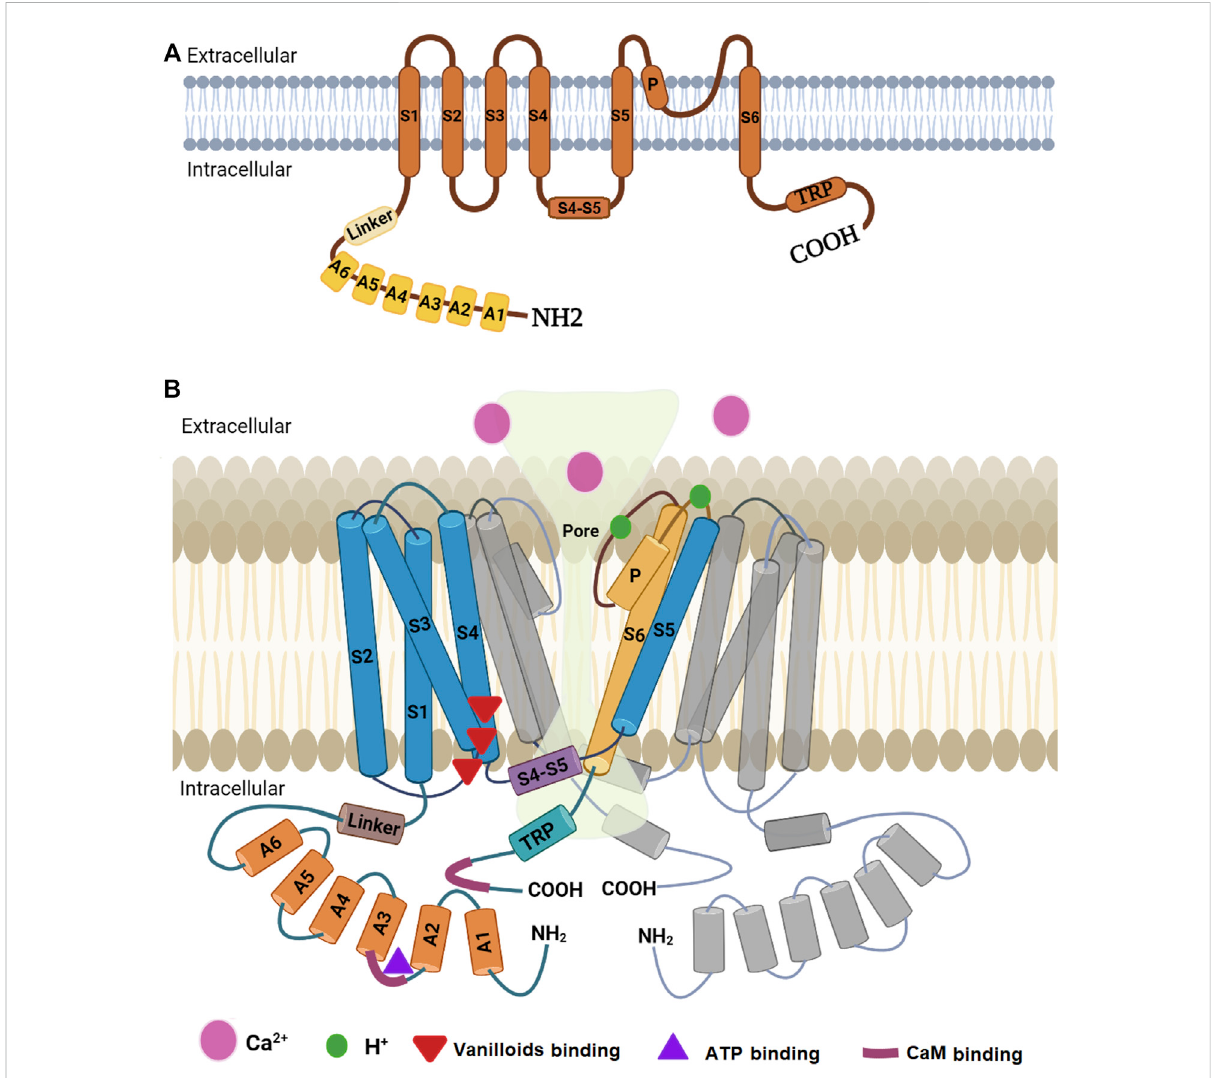
FIGURE 2 Diagrammatic structure of TRPV1. (A) One subunit showing N-terminus containing six ankyrin subunits (A1-A6) and a linker, transmembrane region with six helical segments (S1-S6), a pore loop (P), and a C-terminus containing a TRP domain. (B) Two monomers of the TRPV1 with a pore in the middle. One monomer (colored) is closer to the reader while the other (grey colored) is at 180 ° . The other two monomers have been omitted to show the pore. Part B is modi fi ed from the work of Shuba